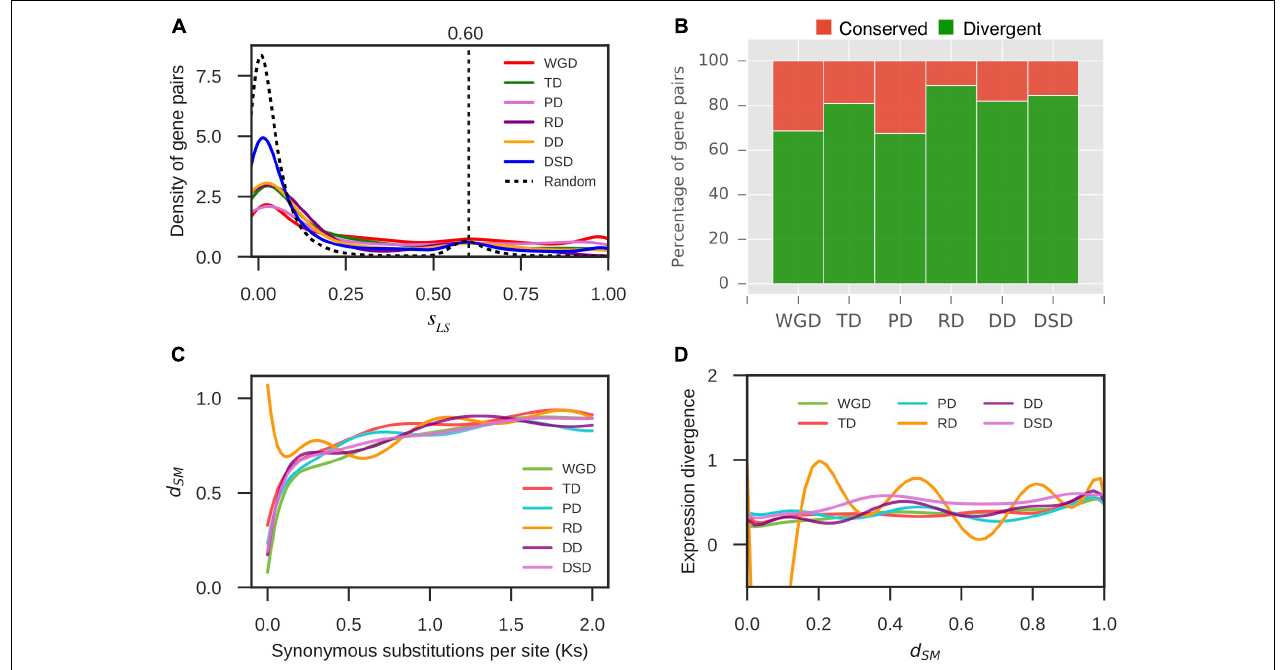
FIGURE 5 | The promoter region divergence between duplicate genes in pear. (A) The density distribution of the shared-motif similarity in the promoter sequence ( s LS ) between two duplicated genes resulting from different modes of duplicated pairs. The vertical dotted line indicates the 95% quantile in the s LS values distribution for 10,000 random gene pairs. (B) The proportion of divergent and conserved gene pairs in the promoter region. (C) The dynamic promoter divergence between duplicate genes with increasing K s values. d SM indicates the shared-motif divergence of the promoter. (D) The dynamic expression divergence between duplicated genes with increasing d SM values.